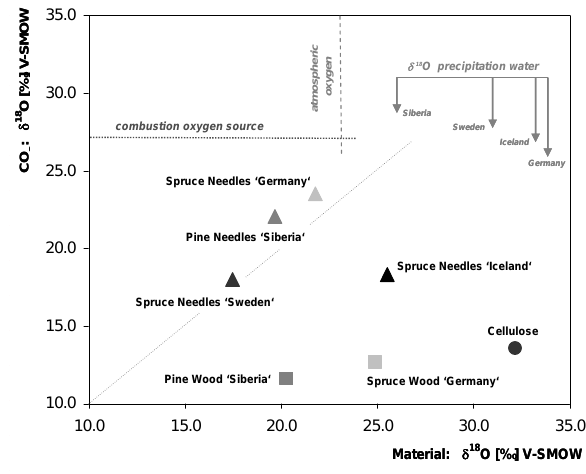
Fig. 5. Isotopic signature of the material’s oxygen and the combustion-derived CO 2 (see also Table 2). Indicated are as well the isotopic signatures of the oxygen source of the combustion ex- periments (dark dotted line), the atmospheric molecular oxygen (vertical dashed line) and the oxygen signature of the precipitation water from the spatial origin of the bulk material samples (arrows; IAEA/WMO,